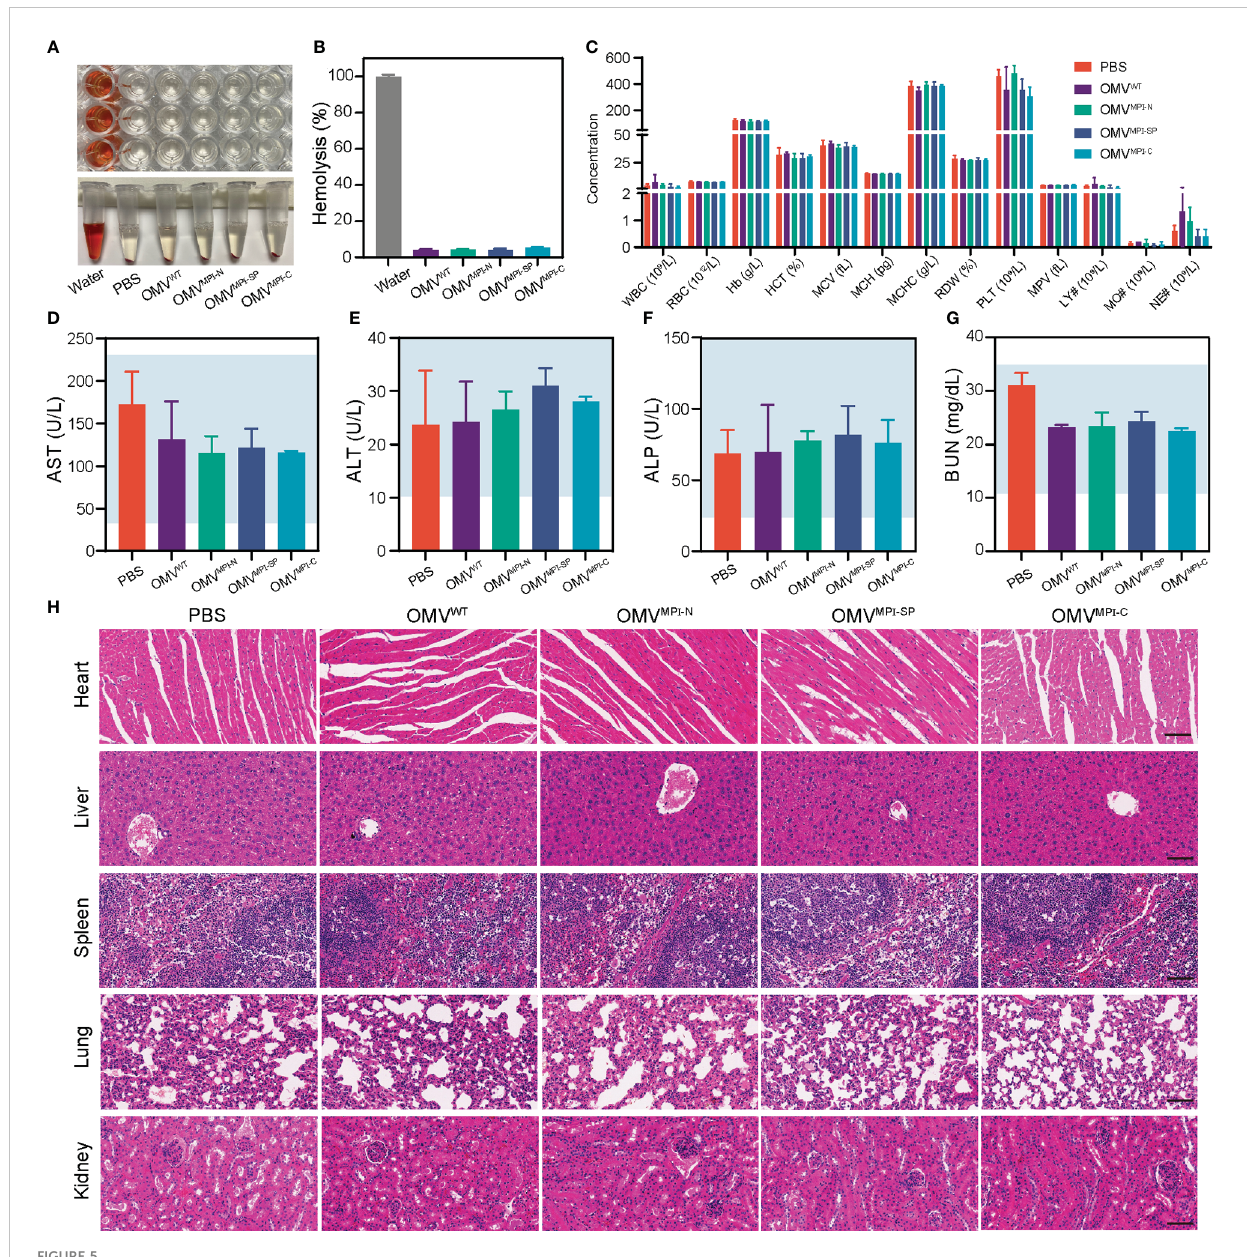
FIGURE 5 Biosafety evaluation of bioengineered OMVs. (A) Hemolytic images of OMV WT , OMV MPI-N , OMV MPI-SP , and OMV MPI-C in tubes and plates. (B) The calculated hemolysis percentages of bioengineered OMVs ( n = 3). (C) Blood routine examination results of tumor-bearing mice from different treatment groups ( n = 3). (D – G) Serum biochemical indexes of AST, ALT, ALP, and BUN of tumor-bearing mice from different treatment groups ( n = 3). Ranges indicated by blue are normal ranges and all the detected serum biochemical indexes were in normal ranges. (H) Histology H&E staining analysis of heart, liver, spleen, lung, and kidney slices obtained from tumor-bearing mice after different treatments. Scale bars = 50 m m. Data in (B – G) are presented as mean ±